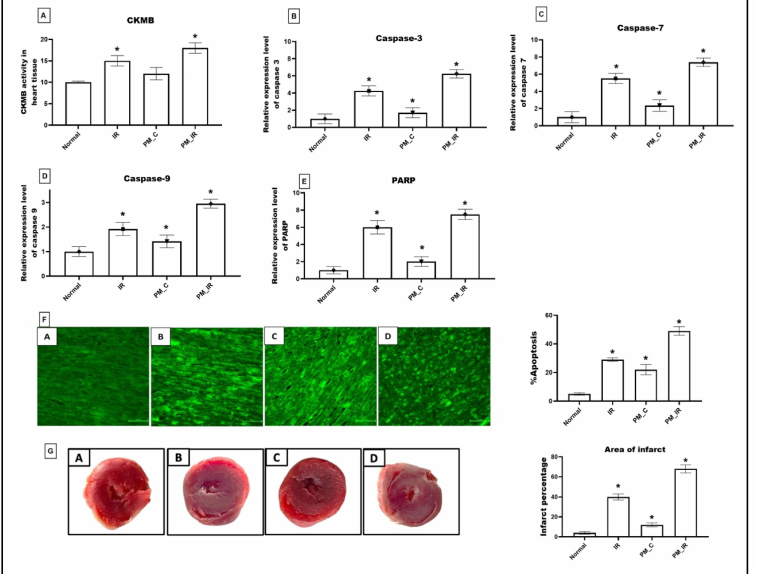
Figure 1. Cardiac injury assessment. ( A ) CKMB level in myocardium. ( B ) Relative gene expression levels of caspase 3. ( C ) Relative gene expression levels of caspase 7. ( D ) Relative gene expression levels of caspase 9. ( E ) Relative gene expression levels of PARP. ( F ) TUNEL staining (40 × magnification) (* p < 0.05 vs. Normal) ( G ) TTC stained myocardium and calculation of area of infarct using ImageJ software version 1.53t (J software, Rockville, MD, USA). Values are mean ± SD, ( n = 6 per group) [Groups: (A) Normal, (B) IR, (C) PM_C, (D)